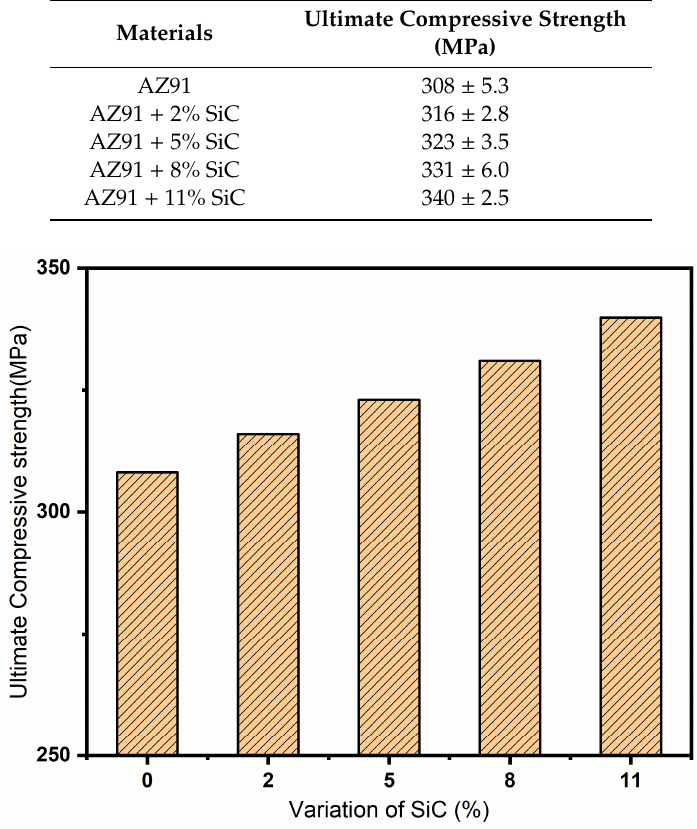
Figure 7. Representation of ultimate compressive strength of alloy and composites with different percentages of SiC.